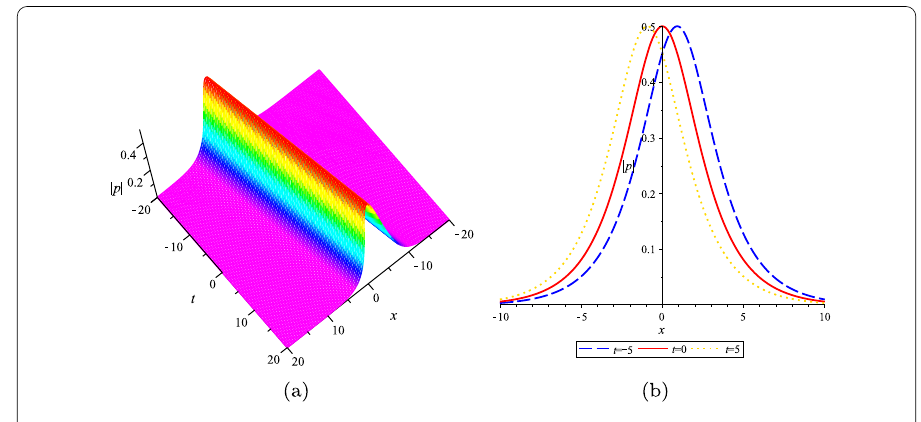
Figure 1 One-soliton solution (26) with ˜ a 1 = 0.3, ˜ b 1 = 0.25, α 1 = β 1 = 1, ξ 1 = 0. ( a ) Perspective view of modulus of p ; ( b ) The soliton along the x -axis with different time in Fig. 1(a)